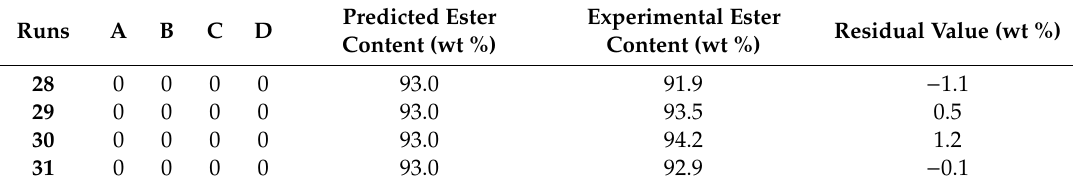
Figure S1: Experimental methyl ester content versus predicted values, Table S1: Experimental conditions which lead to an ester content greater than 96.5 %, according to the